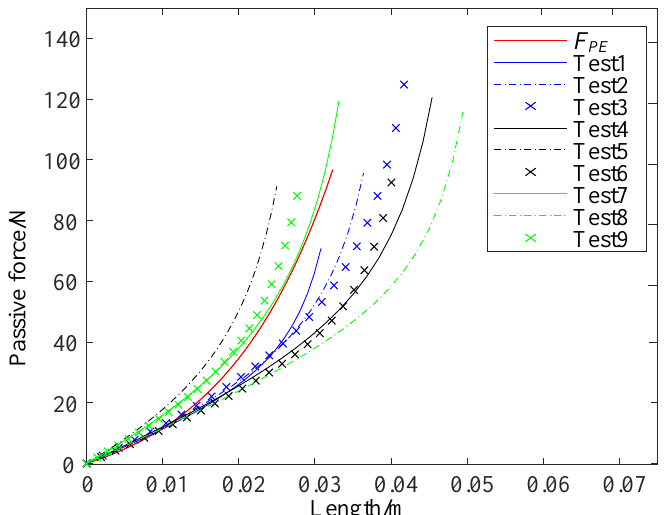
Figure 6. Simulation results of passive force–displacement relationship obtained by nine groups of parameters.